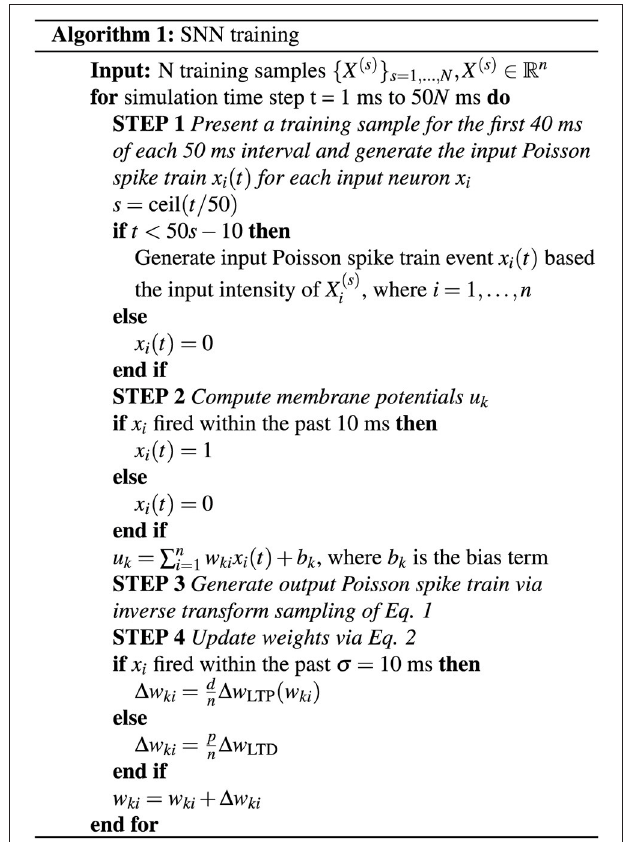
FIGURE 4 | SNN training